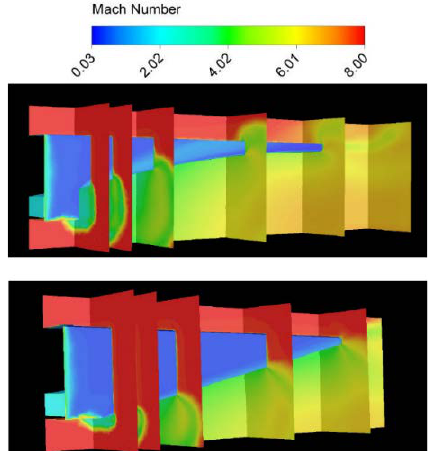
Figure 24. Mach number contours for SERN DP456 with small ( top ) and large ( bottom ) side fence.